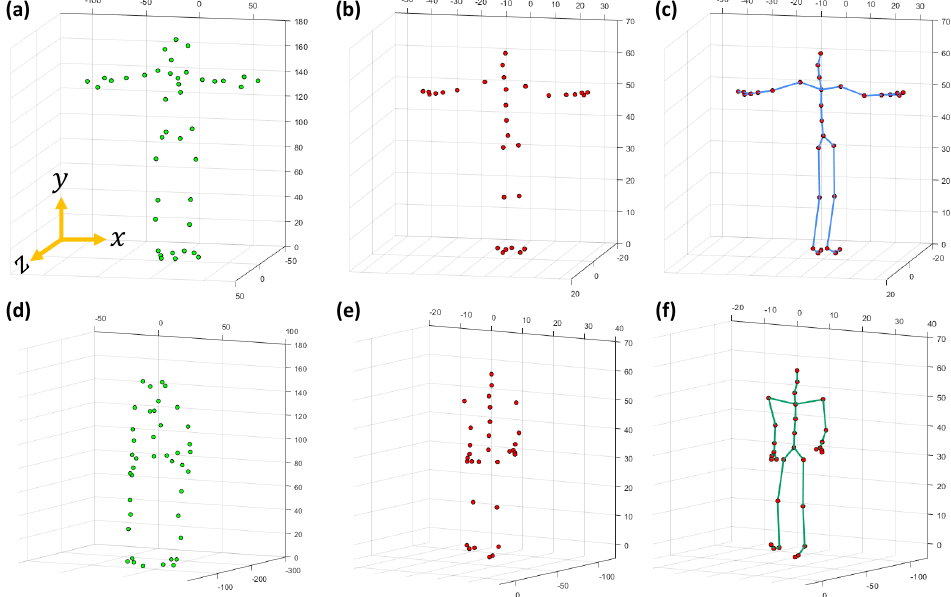
Figure 2. ( a ) The details of the markers (c3d file), ( b ) AMC file, and ( c ) the skeleton (ASF file) of the HDM05 MoCap dataset [9], while ( d – f ) elaborate on the details of the marker (c3d file), the AMC file and the skeleton (ASF file) of the CMU MoCap dataset [56], respectively.